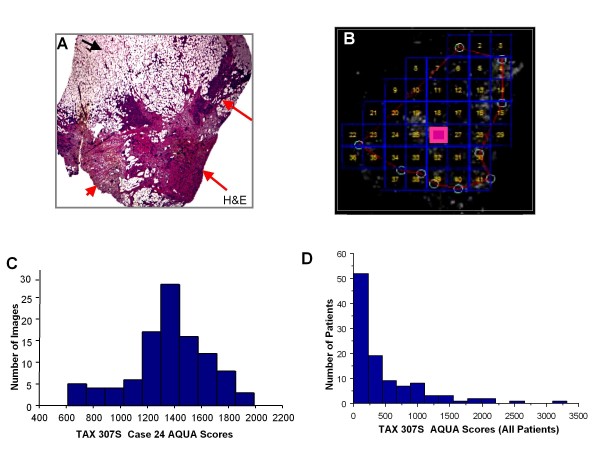
MAP-tau expression and frequency distribution in TAX 307S whole tissue sections. (a) Whole section breast tumor tissue from patient case 24 stained with hematoxylin and eosin showing dark pink staining of tumor cytoplasm compared with blue nuclei staining (red arrows); remaining light pink or non-staining, mesh-like areas comprised of breast adipose tissue (black arrow). Original magnification × 4. (b) Whole tissue slide of breast tumor tissue from panel a (case 24) stained with MAP-tau-Cy5 and analyzed using AQUA digital pathology algorithms. A matrix captured 103 quadrants (41 quadrants displayed in panel b and was used to systematically capture each field of view (FOV), creating 103 unique expression scores for case 24. Original magnification × 4. (c) Frequency distribution for MAP-tau quadrant scores from case 24 with mean and median AQUA scores of 1357 and 1369, respectively, and a score range of 610 to 1986. FOVs were used to generate a frequency distribution for each case in the TAX 307S cohort (n = 140). The median AQUA score from each case was used in all cohort analyses. (d) Distribution of MAP-tau expression in TAX307.